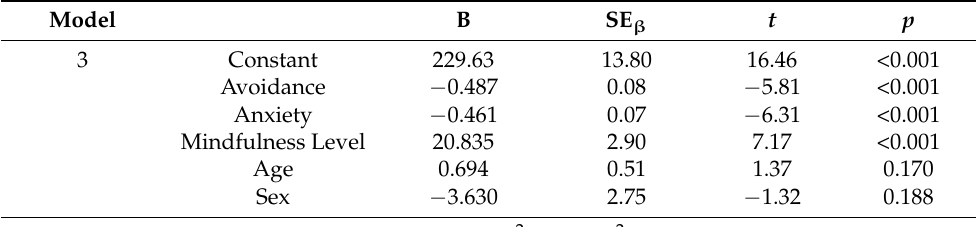
Table 6. Model with avoidance, anxiety, mindfulness category, and control variables. Model